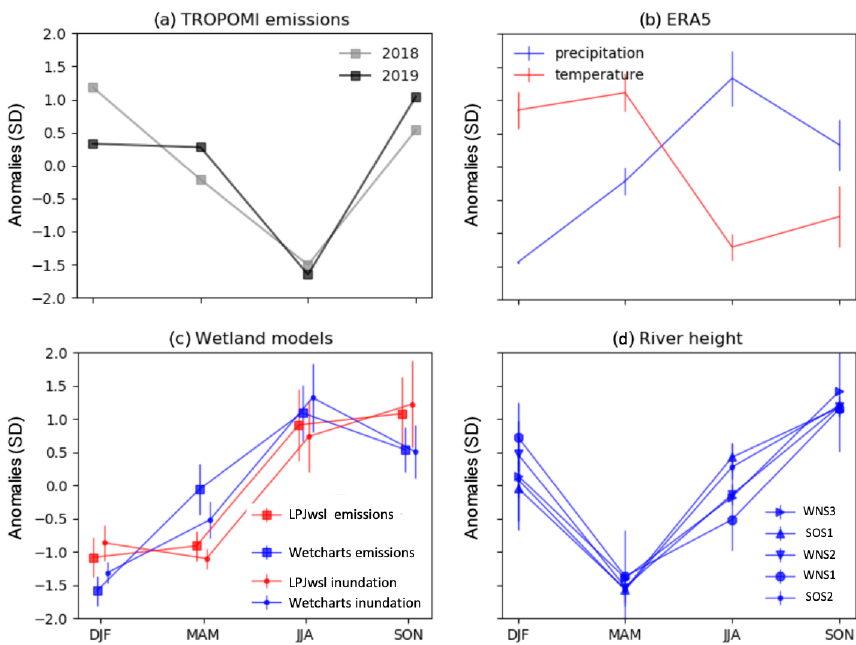
Figure 5. Mean seasonal cycles expressed in units of the standard deviation of the respective time series. (a) Emission estimates from TROPOMI; (b) precipitation and temperature from ERA5 (2010–2019); (c) emissions and inundation extent from the process models LPJ- wsl and Wetcharts extended ensemble; (d) river water height measurements at the altimetry sites given in Fig. 1b. The vertical bars represent 1SD spread over different years.